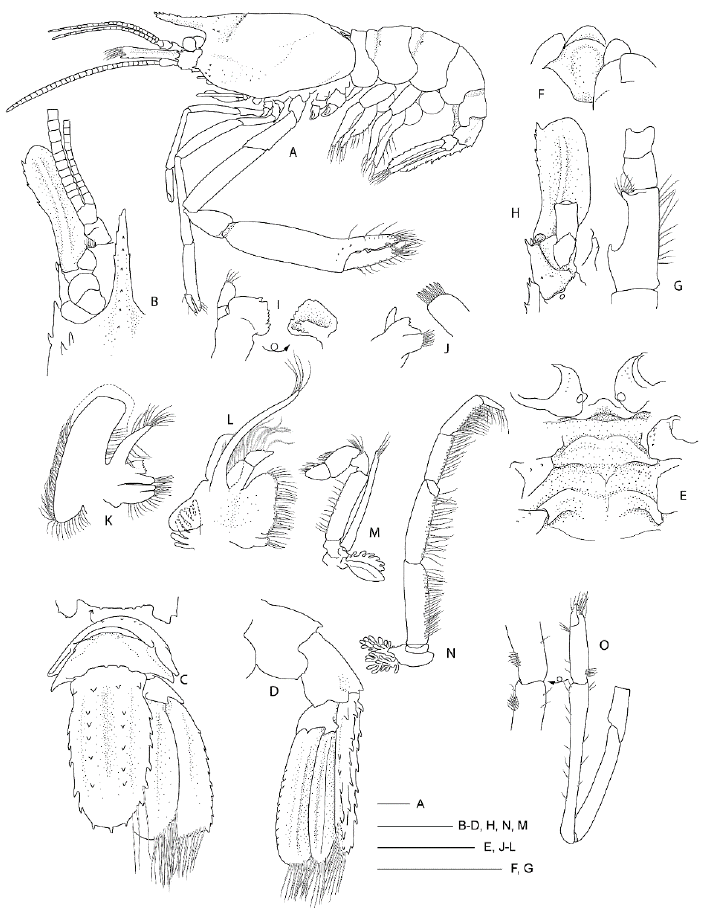
Figure 18. Spongicaris antipodes sp. nov., holotype F ov. (NMNZ CR.025704). ( A ) Habitus, lateral. ( B ). Anterior portion of carapace and cephalic appendages, dorsal. ( C ) Pleonites 6, urosome and telson, dorsal, with inset of dorsal view of pleonite 5. ( D ) Pleura 5–6, urosome and telson, lateral. ( E ) Thoracic sternites 6–8 with coxae of pereiopods, ventral. ( F ) Epistome, labrum partially covered by following mouthparts, ventral. ( G ) Right antennular peduncle, ventral. ( H ) Right antennae with inset view of mesial margin of basicerite. ( I ) Right mandible, inner and outer view. ( J ) Right maxillule with broken upper lacinia and left maxillule upper lacinia. ( K ) Right maxilla. ( L ) Right Mxp1. ( M ) Left Mxp2. ( N ) Right Mxp3. ( O ) Right P1, lateral, with inset detail of carpo-propodal setiferous organ. Scale bars = 2 mm.